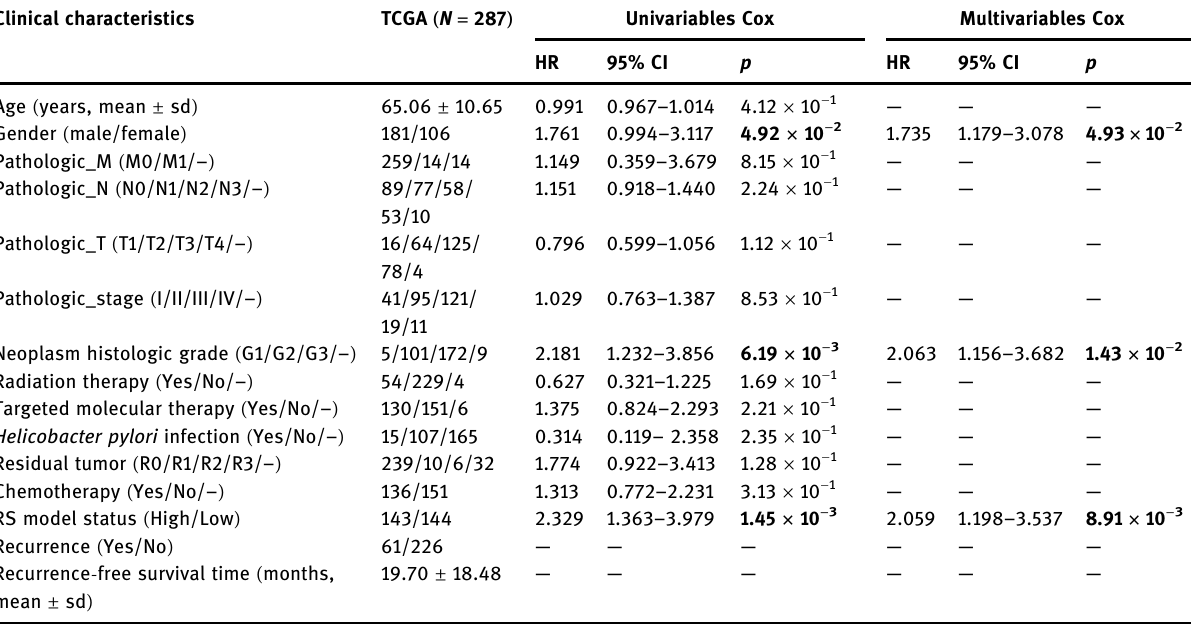
Table 2: Uni - and multivariable Cox regression analysis of clinical features and risk score model status Clinical